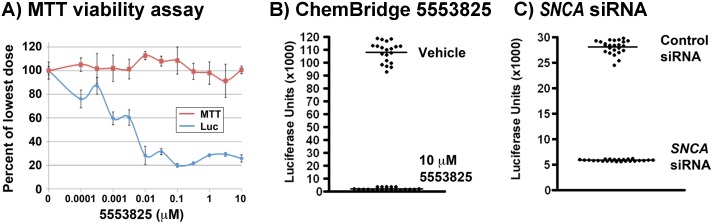
High throughput screening quality metrics for the Luc6B cell line.
A&B) Quality metrics for Luc6B treated with luciferase inhibitor ChemBridge 5553825 vs. DMSO. (A) We identified ChemBridge 5553825 as a potent ATXN2-luc inhibitor reducing expression by 80% at 0.1 nM (blue) that does not inhibit cell growth at any tested dose (red, MTT assay). Tests were conducted using SH-SY5Y cells stably expressing ATXN2-luc, with treatment time of 48 hours. We ultimately determined that ChemBridge 5553825 is a luciferase inhibitor. (B) 25,000 Luc6B cells per well were exposed to 10 nM compound in 50 μl total volume in a 384 well plate (n = 20 per condition). Luciferase expression was determined after 24 hrs. Shown is a scatter plot with means indicated. Mean and SD for 5553825 and 1% DMSO vehicle were 2023±1030 and 108,252±7929, respectively. Using these values, the computed quality metrics for Luc6B when treated with luciferase inhibitor are as follows: Z’-score: 0.75, Signal/Noise (S/N): 15.4, Signal/Background (S/B): 53, Coefficient of variation (C
v): 6.5%. (C) Quality metrics for Luc6B cells treated with SNCA siRNA vs. control siRNA. Luc6B cells were transfected with SNCA siRNA or control siRNA for 5 days, then trypsinized and distributed at 30,000 cells/well in 24 wells of a 384 well plate, cultured for an additional 24 hours, after which time luciferase assays were performed. Shown is a scatter plot with means indicated. The Mean and SD for SNCA-siRNA and control siRNA were 5,886±163 and 28,093±1,344, respectively. Using these values, the computed quality metrics for Luc6B when treated with SNCA-siRNA are as follows: Z’-score: 0.80, S/N: 18.8, S/B: 4.8, C
v: 5.3%. Computations were made as follows: Z’-score = 1-[(3(σexp+σcont))/|μexp-μcont|]; S/N = |μexp-μcont|/|σexp-σcont|, S/B = μcont/μexp; C
v = 1/S/N, where μ and σ are the mean and SD, respectively.